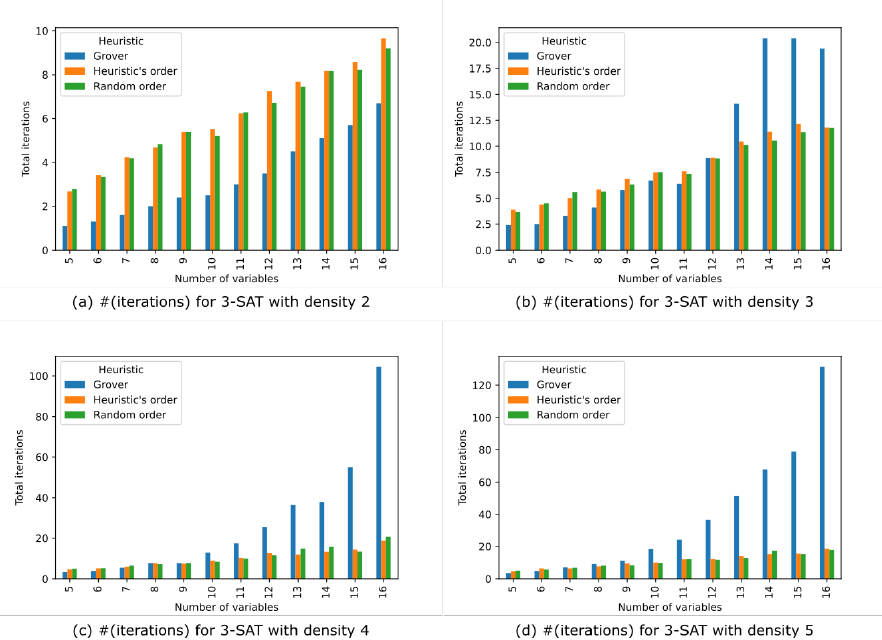
Figure 7. Comparisons of number of Grover’s iterations for different densities on 3-SAT